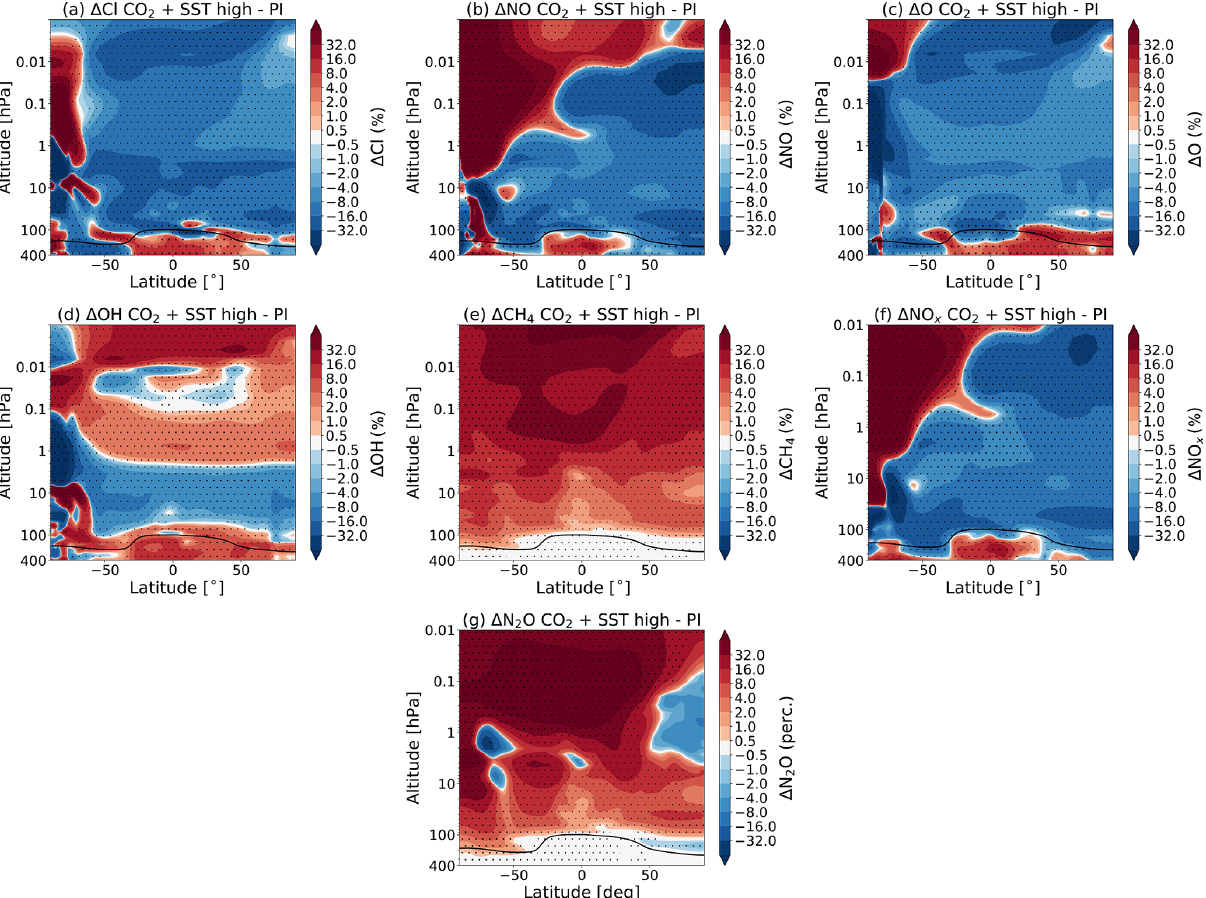
Figure 4. The percentage change in the zonal and monthly mean concentration of Cl (a) , NO (b) , O (c) , OH (d) , CH 4 (e) , NO x (f) and N 2 O (g) in July due to the combined effect of the CO 2 increase and SST changes (experiment S3 vs. C1) as simulated by WACCM. The dotted regions indicate the regions where the data reach a confidence level of 95%. The tropopause height is indicated as in Fig.